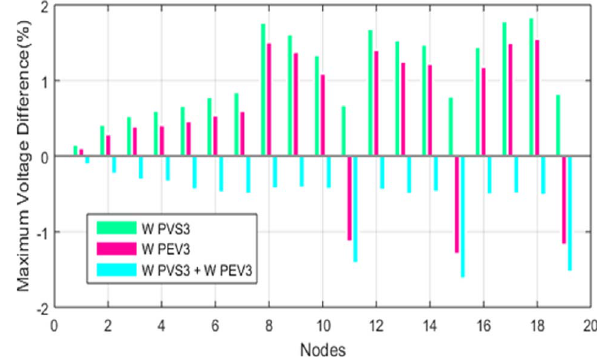
Figure 20. Analysis of day-to-day outlines of the feeder 1 to 2 loads (any type) thru wintertime.